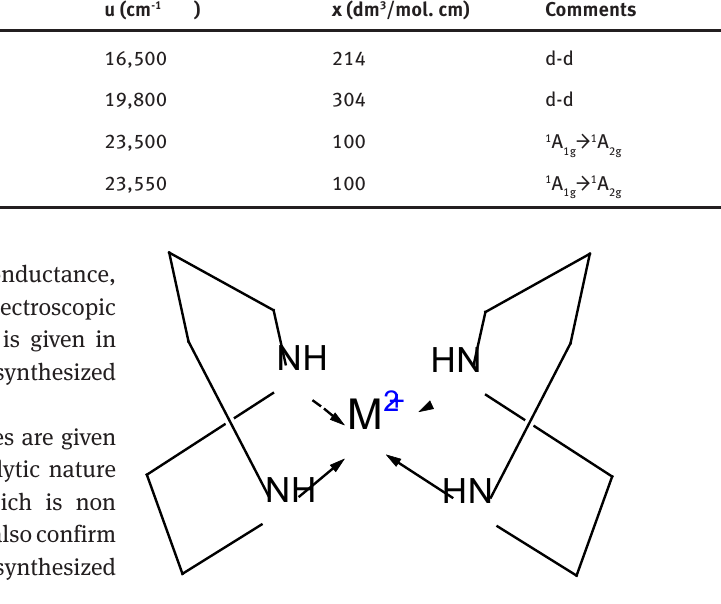
Table 3: Electronic absorption values for DACH complexes.